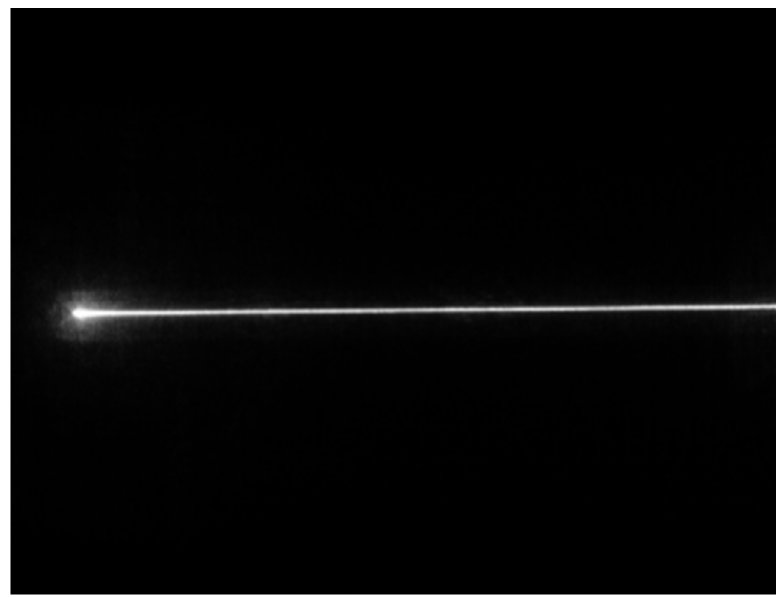
Figure 3. Light stripes.